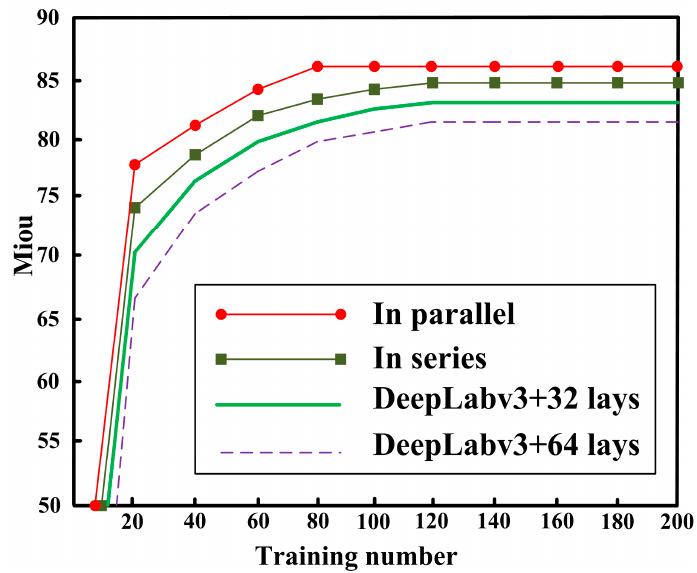
Figure 13. Network convergence curve.